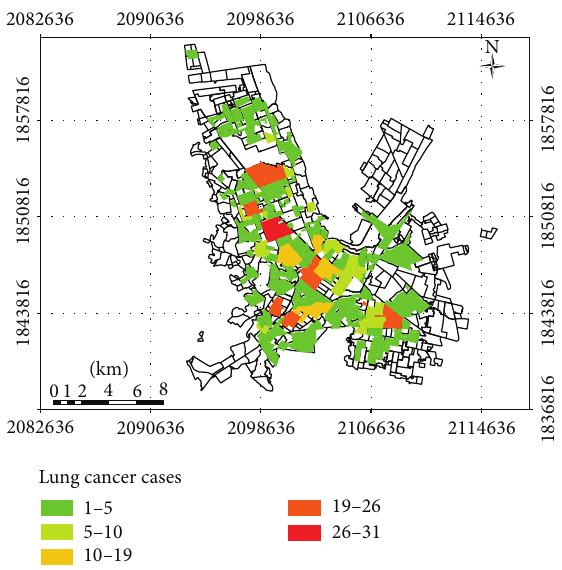
Figure 5: Chihuahua City map with the location of deaths by LC between 2004 and 2010. Lung cancer cases mean the number of deaths by neighborhood, according to the information provided by Secretary of Health. Colors allow appreciating the neighborhoods with more deaths by LC.